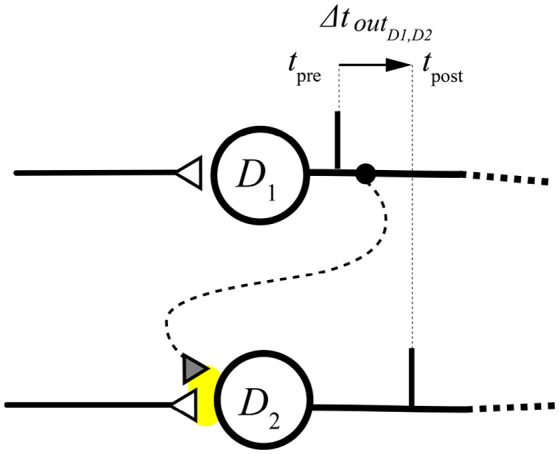
Lateral excitatory heterosynaptic junction. The area of synapse modification is highlighted in yellow.